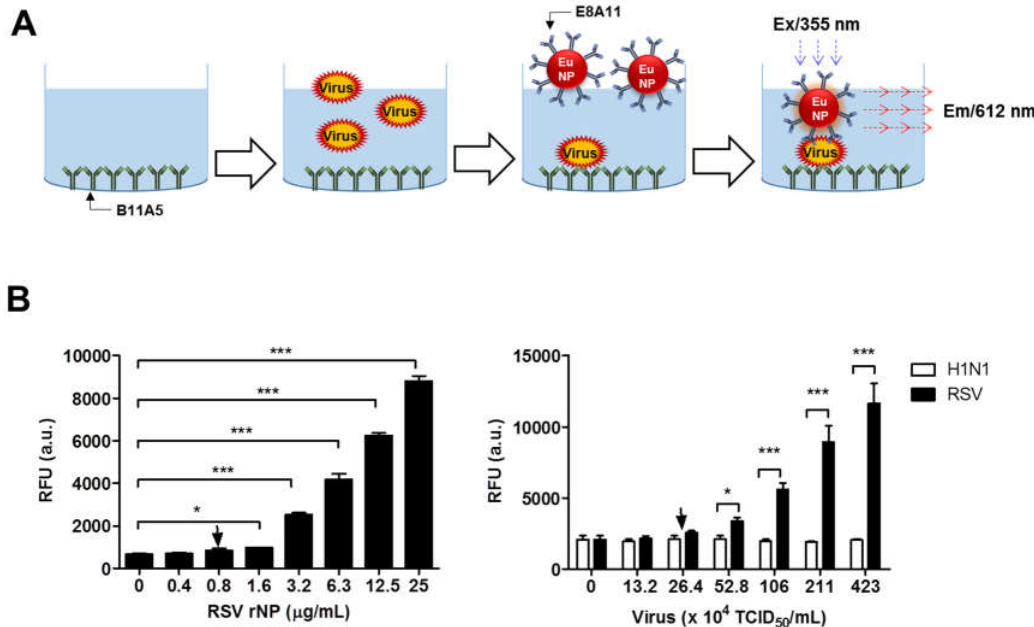
Figure 4. Performance of sandwich fluorescence-linked immunosorbent assay (FLISA) using two novel monoclonal antibodies for the detection of respiratory syncytial virus (RSV). ( A ) Sandwich FLISA using B11A5 (capture) and europium nanoparticle (Eu NP)-conjugated E8A11 (detection) was conducted with serial dilutions of RSV recombinant nucleoprotein (rNP) and virus. Fluorescence was measured for bound Eu NP-conjugated E8A11 (excitation at 355 nm and emission at 612 nm). ( B ) Serially diluted RSV rNP antigen, from 0.4 µ g/mL to 25 µ g/mL, and virus, from 13.20 × 10 4 to 4.23 × 10 6 TCID 50 /mL, were tested by FLISA. H1N1 was used as a negative virus control. Data ( n = 3) are shown as the mean ± SD. a.u., arbitrary units; LOD, limit of detection. One-way ANOVA; * p < 0.05; *** p < 0.001.